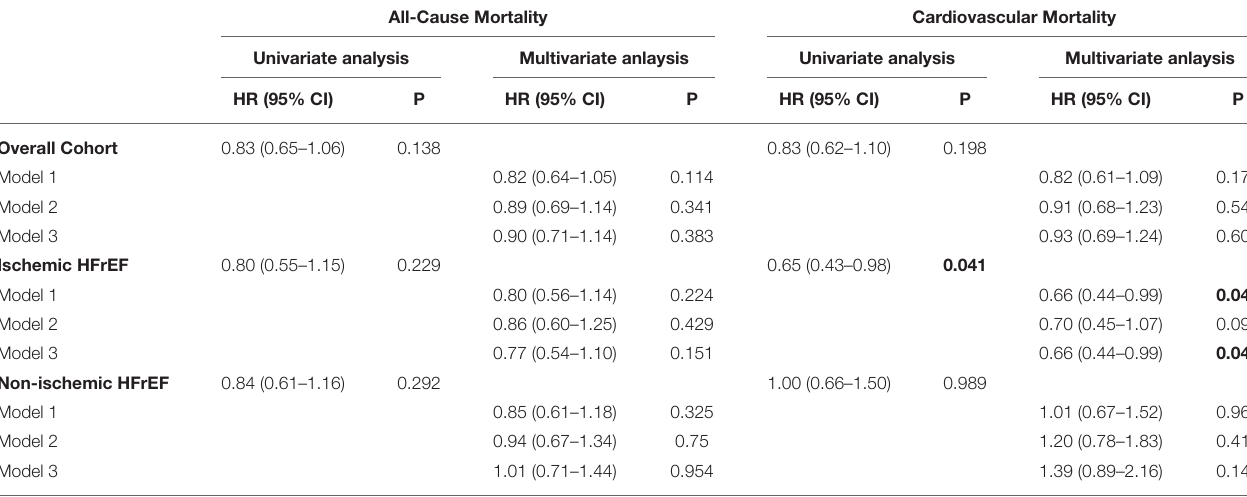
TABLE 2 | Univariate and multivariate Cox regression analysis for T 50 and all-cause and cardiovascular mortality. All-Cause Mortality Cardiovascular Mortality Univariate analysis Multivariate anlaysis Univariate analysis Multivariate anlaysis